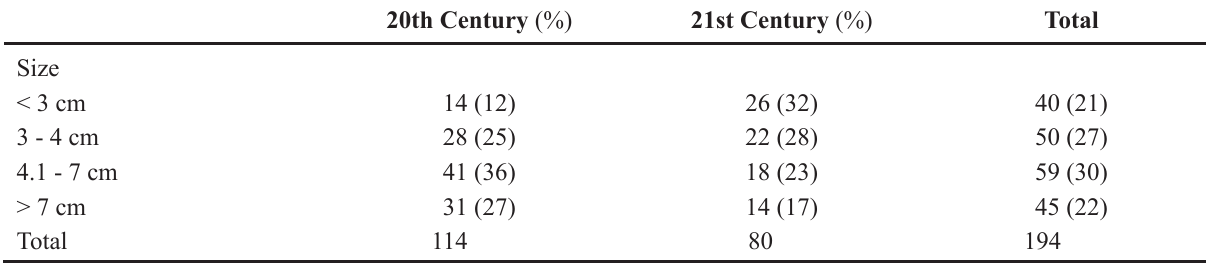
Table 4 – Distribution of tumor sizes between the end of the 20th century and the beginning of the 21st century.